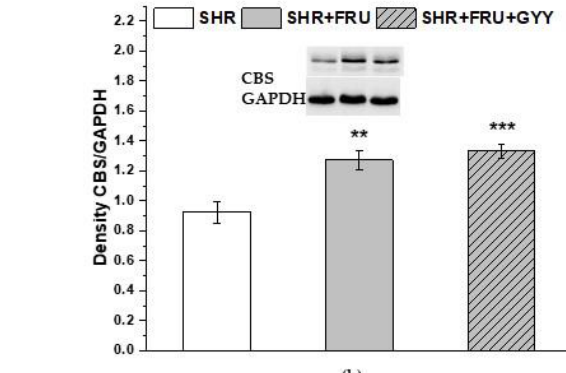
(IL-6) was evaluated in the left ventricle and aortic tissue (Table 2). In the aortic tissue, there were no differences in protein expression of TNF- α and IL -6 among the experi- mental groups. We observed a significant increase in the IL-6 ( p < 0.001) as well as TNF α ( p < 0.001) in the left ventricle in rats treated with fructose. Whereas the treatment with GYY-4137 reversed the increased expression of TNF α ( p < 0.01) to the level of the control group, the expression of IL-6 remained increased. Additionally, there were significant in- creases in conjugated dienes (CD) concentrations in the left ventricle of rats fed with fruc- tose ( p < 0.01), which were reversed by the treatment with GYY-4137 ( p < 0.05). Table 2. Protein expression of IL-6 and TNF α and Conjugated Dienes Concentration. Parameter